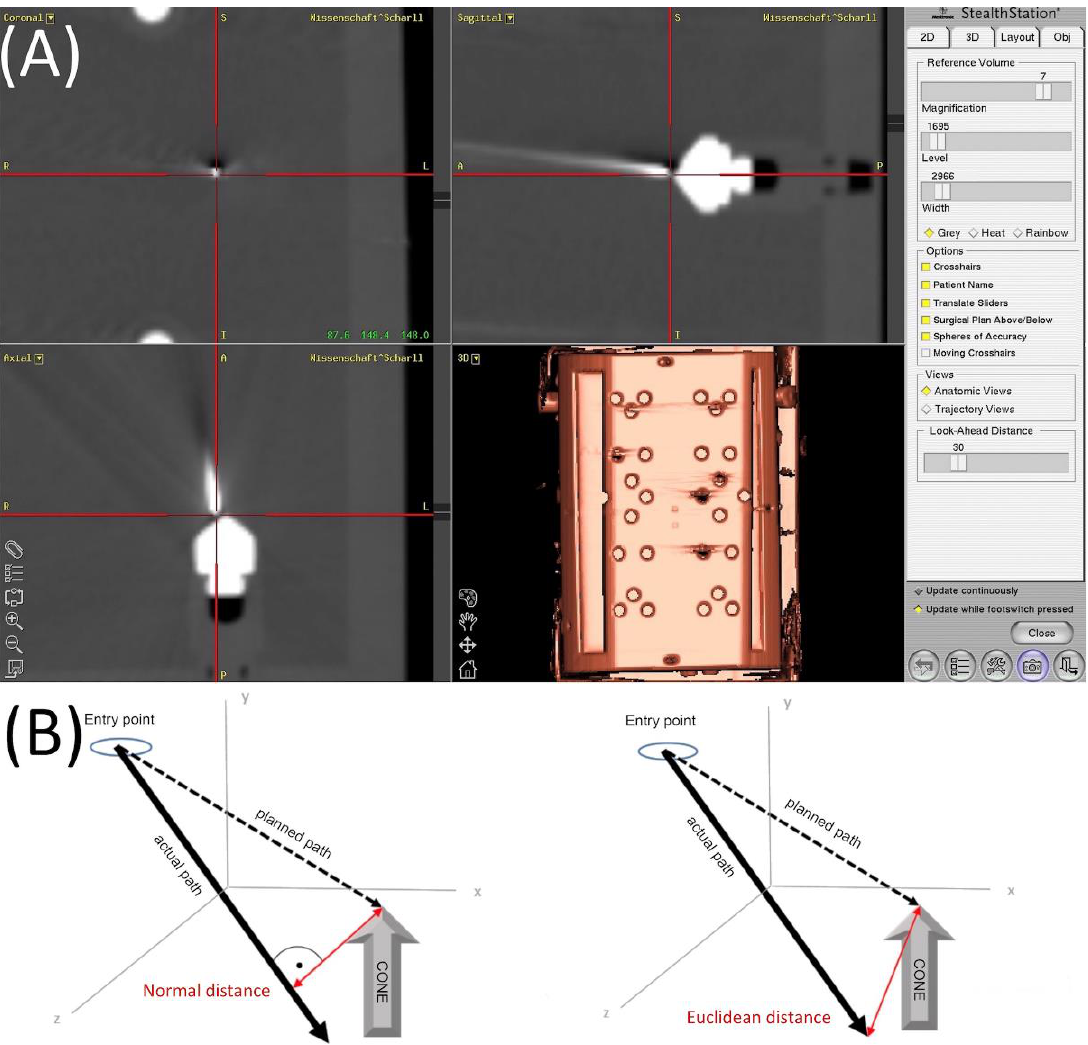
Figure 3. ( A ) Screenshot of the Medtronic Stealth Station Treon to evaluate the needle positioning accuracy with the control CT-data. The x, y and z coordinates (displayed in the left upper quadrant) were measured by positioning the crosshairs in all three planes. The data was then transferred to an Excel spreadsheet for the calculation of the Euclidean and the lateral positioning error. ( B ) The Euclidean distance determines the gap between two points in a multidimensional space. It is calculated using the coordinates of the actual position of the needle tip and the target point, indicating the deviation in the direction of the needle placement. The normal distance describes the shortest possible distance between a point and a straight line.